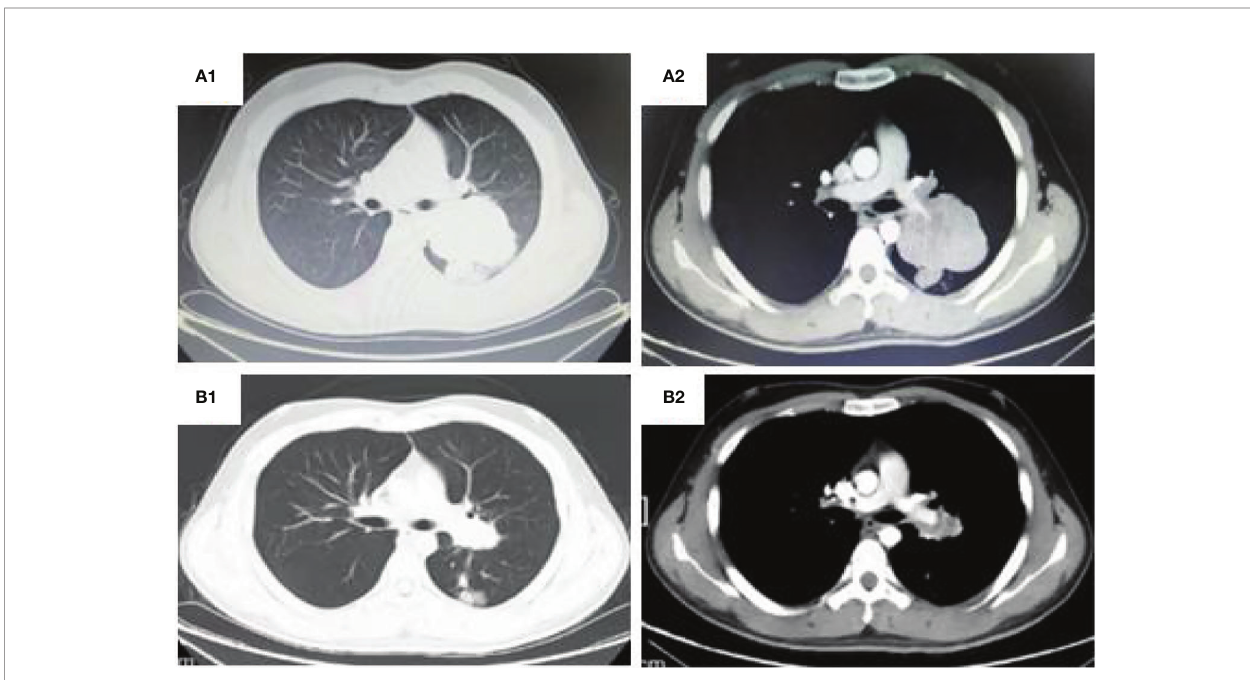
FIGURE 1 | CT thorax: (A1, 2) (Shanxi Provincial Cancer Hospital,2021-02-03) shows a large irregular and well-de fi ned border mass lesion measuring 7.7×6.3 cm with inhomogenous enhancement beside the left hilus pulmonis across the interlobar fi ssure and an enlarged mediastinal lymph node measuring 2.7×1.9 cm. (B1, 2) . (Shanxi Provincial Cancer Hospital,2021-05-12)Tumor was remarkable reduced to 2.5*3.4cm and the mediastinal lymph node was 1.2